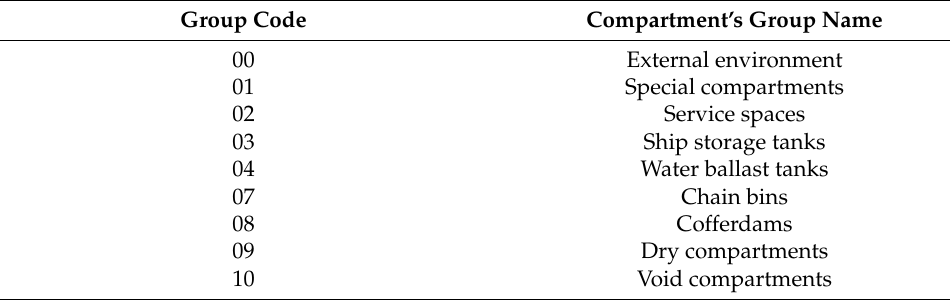
Table 1. Classification of the ship